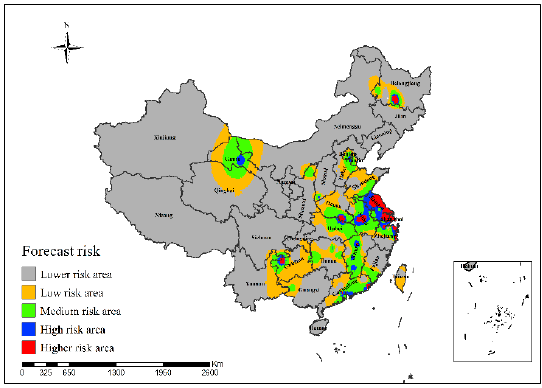
Figure 16. Risk simulation results of H7N9 outbreaks in China in 2016.